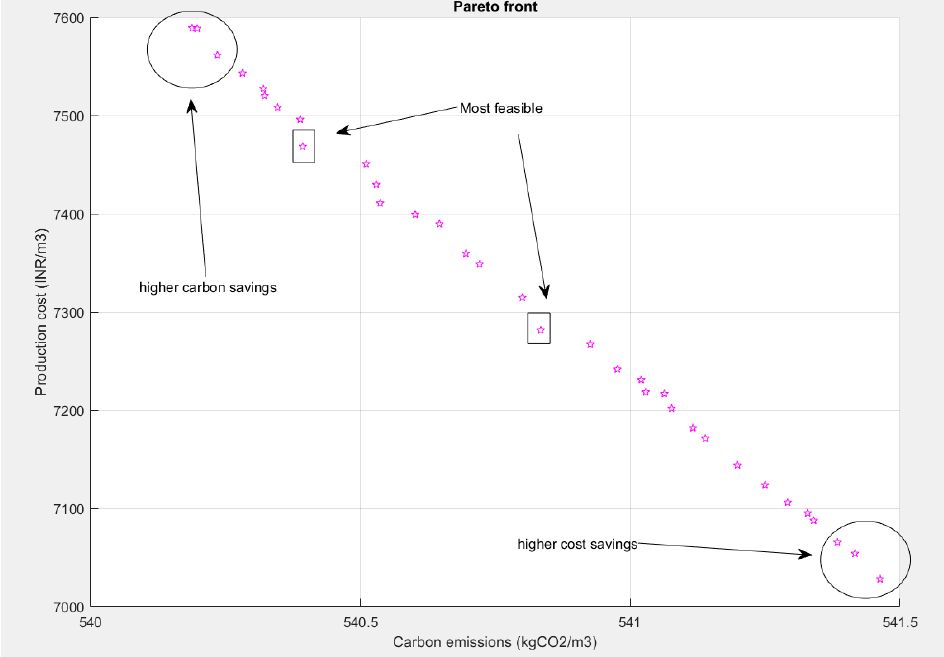
Figure 9. Pareto spread with non-dominated optimised solutions . Table 6. Fibre contents (in kg) in the optimal mix designs (per m 3 ).